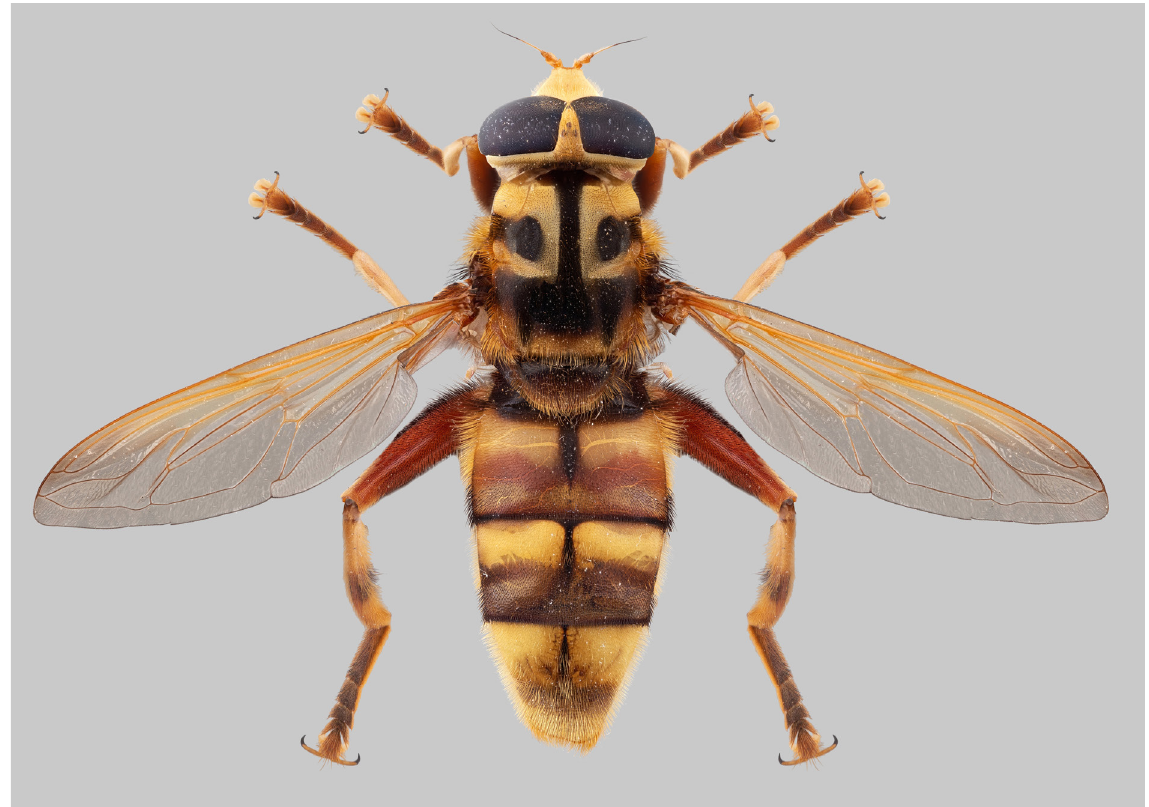
Fig. 4. Milesia crabroniformis (Fabricius, 1775), ♂, (SBH), habitus dorsal. Collected in France, Midi- Pyrénées, 4 August 2010, leg. and coll. S.